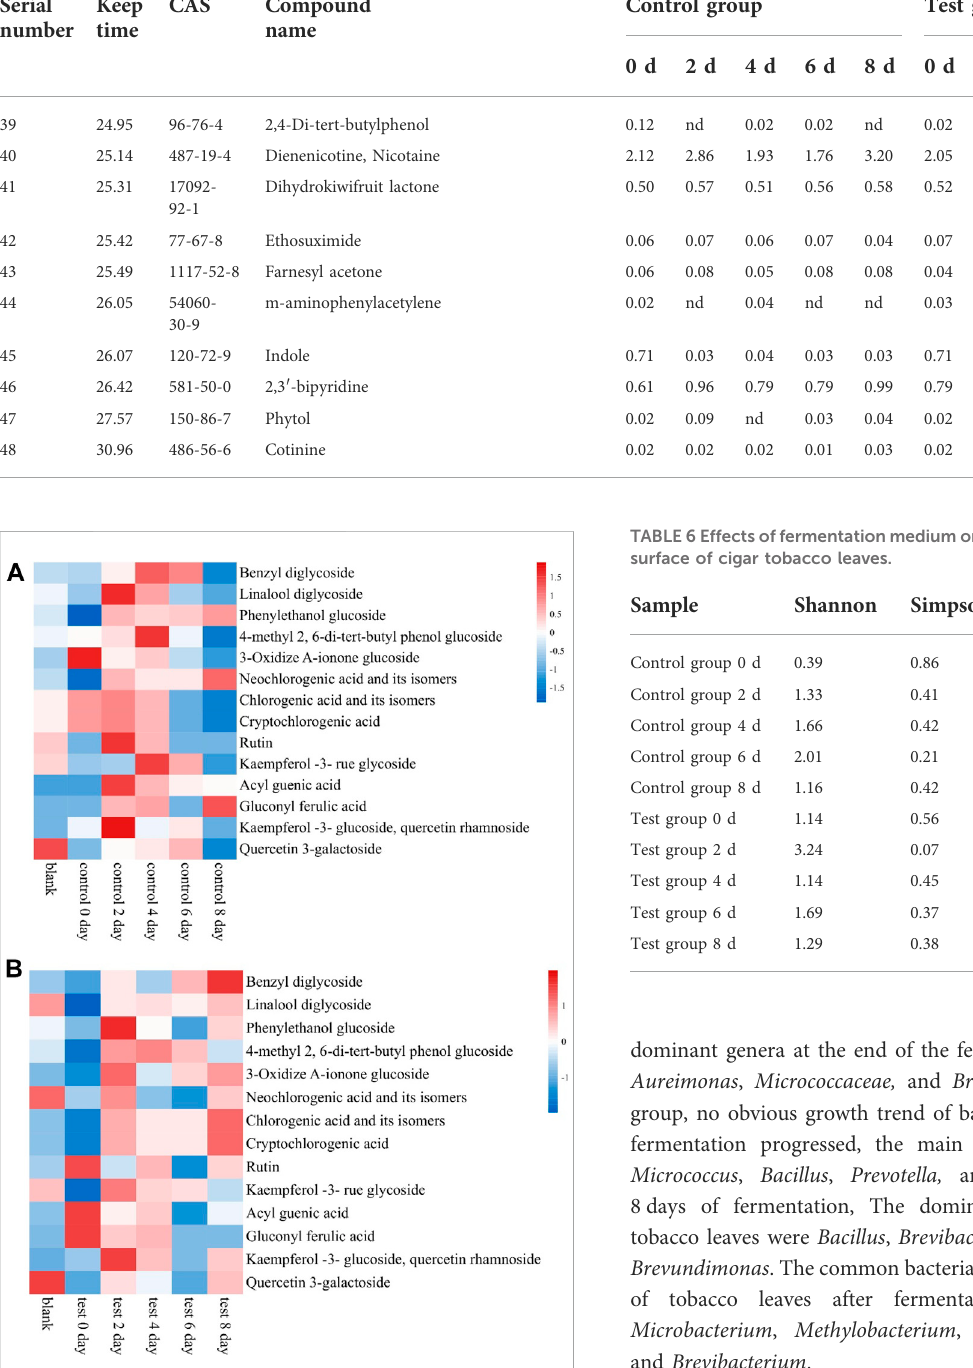
FIGURE 4 Effectsofmediumfermentationonaromaprecursorsofcigar tobacco. Note: (A) is the control group, and (B) is the test group.